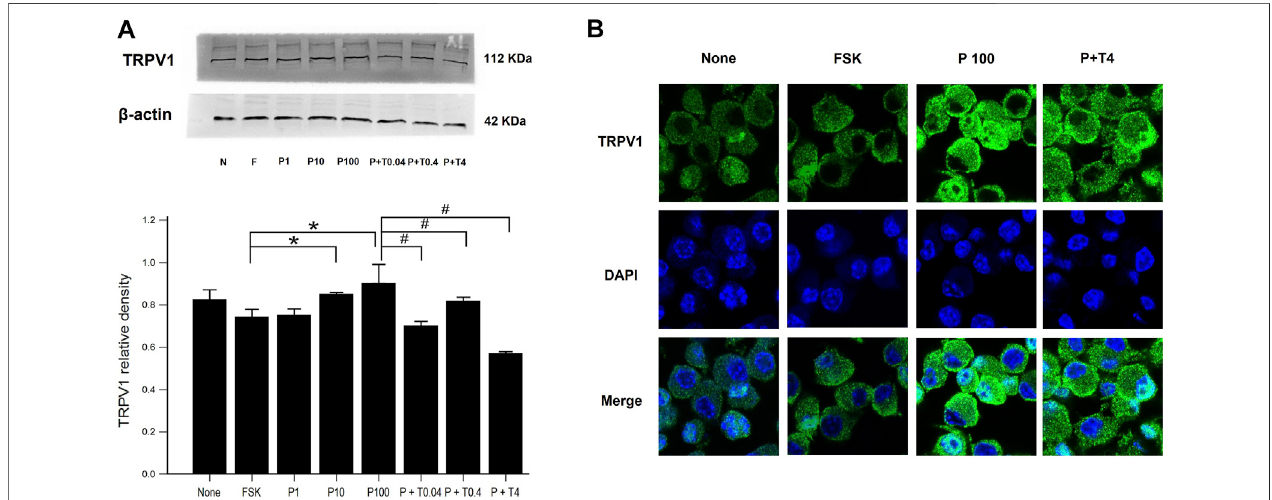
FIGURE 2 | TRPV1 expression in 50B11 cells. (A) Western blot analysis for TRPV1. Quanti fi cation of the basal levels of TRPV1 relative to those of β -actin. (B) TRPV1 (green) expression in a non-treated 50B11 cell; only FSK, PAC (100 ng/ml) on differentiated cells, and PAC (100 ng/ml) with TMI-1 (4 ng/ml) on differentiated cells.CellswerestainedwithAlexaFluor488,andthenucleuswascounterstainedwithDAPI(blue).Datawerepresentedasthemedianandinterquartilerange(IQR)and analyzed using the Kruskal-Wallis test followed by the Conover test ( n = 3 per group). * p < 0.05 compared to the FSK; # p < 0.05 compared to the P100.